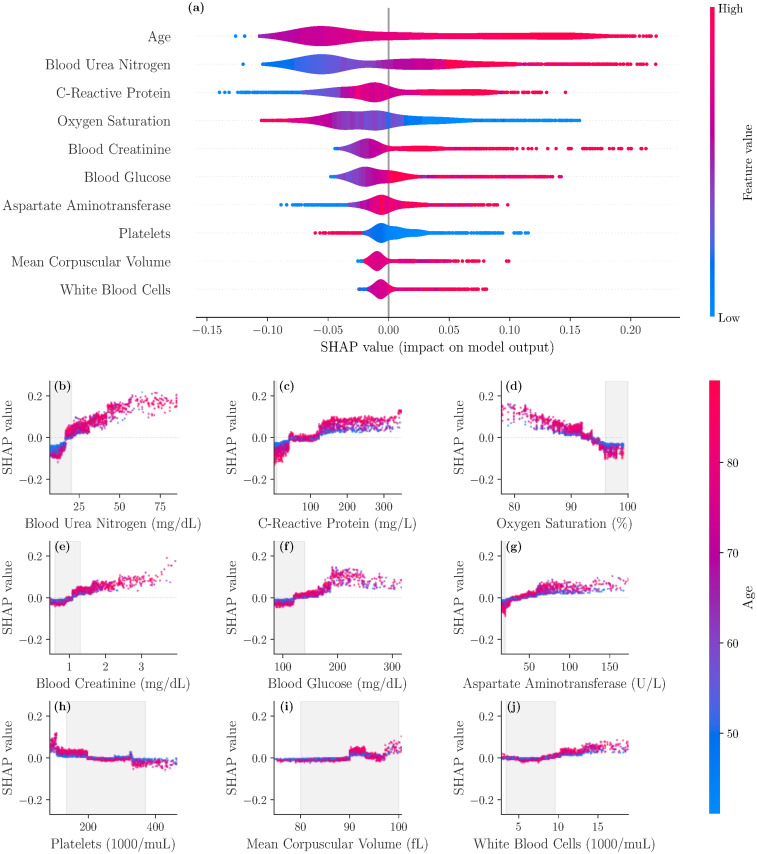
SHAP importance plots for final model.The top 10 features are displayed in panel (a), ordered by decreasing significance. For a given feature, the corresponding row indicates the SHAP values as the feature ranges from its lowest (blue) to highest (red) value. Panel (b)-(j) display the individual feature plots and the impact of each feature on the mortality risk (colors indicate the age here) with gray areas indicating reference ranges.